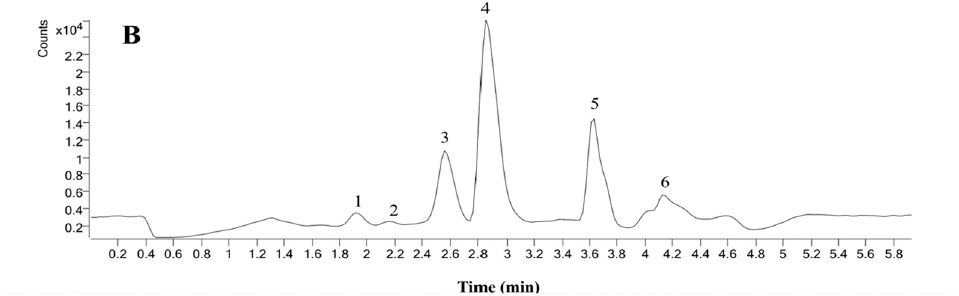
Figure 6. HPLC-MS chromatogram: ( A ) mixed standard solution and ( B ) sample solution. Note: 1 is umbelliferone, 2 is nodakenin, 3 is xanthotoxin, 4 is bergapten, 5 is imperatorin and 6 is decursin.